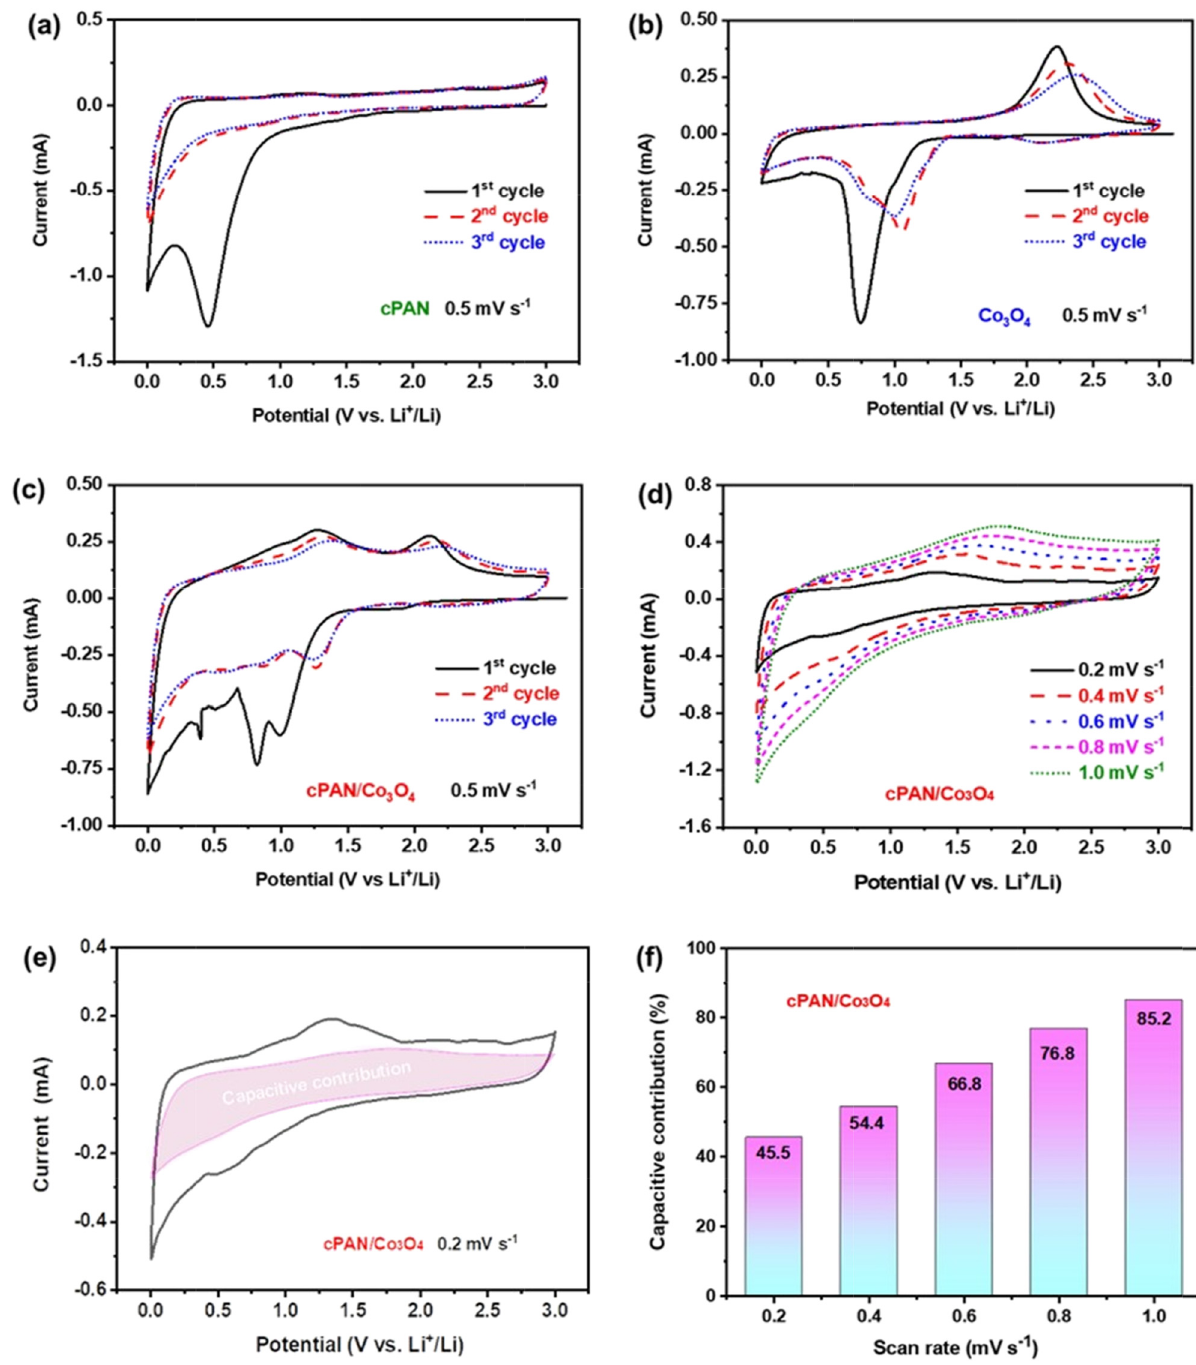
Figure 4: Cyclic voltammograms of ( a ) cPAN, ( b ) Co 3 O 4, and ( c ) cPAN/Co 3 O 4 nano fi ber - based half - cells cycled between 0.001 and 3 V ( vs Li/ Li + ) at a scan rate of 0.5 mV s − 1 . ( d ) CV curves at various scan rates from 0.2 to 1.0 mV s − 1 , ( e ) the decoupling of capacitive contribution ( shadow ) at 0.2 mV s − 1 , and ( f ) the normalized capacitive contribution at di ff erent scan rates for the cPAN/Co